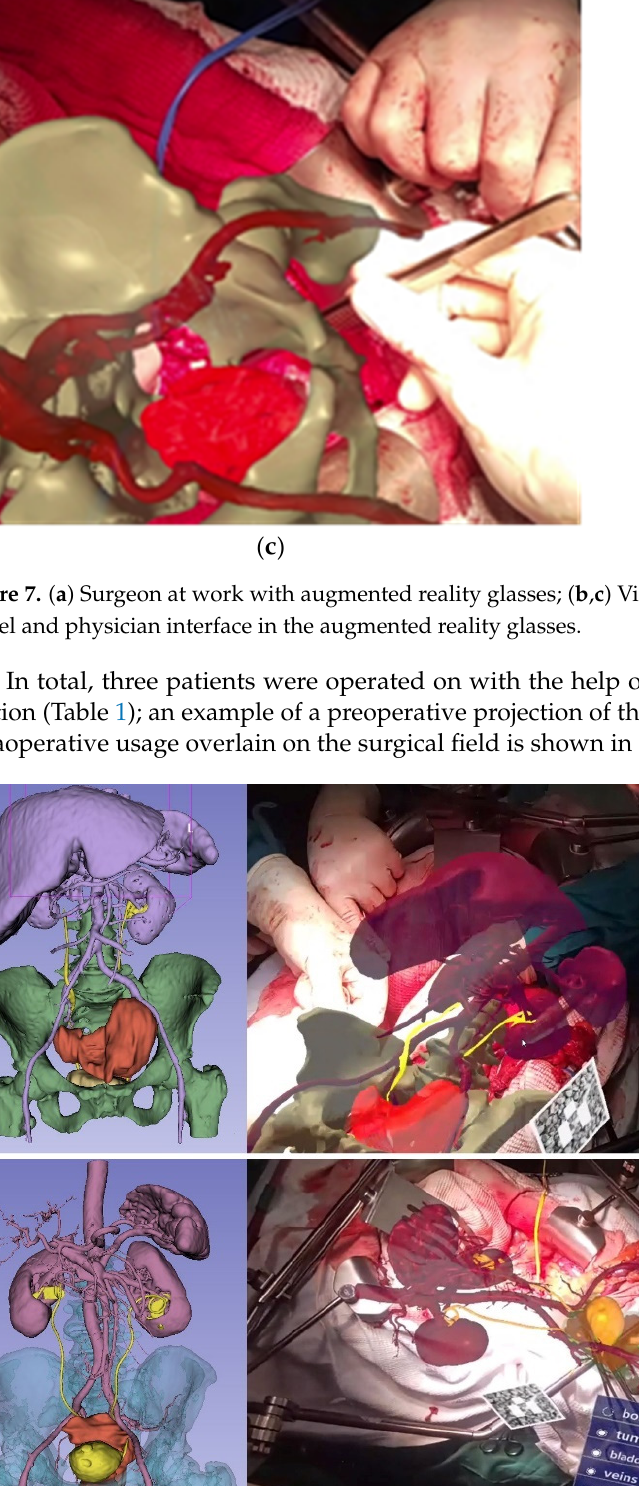
Table 1. Patients with invasive (pin) fixation of marks.